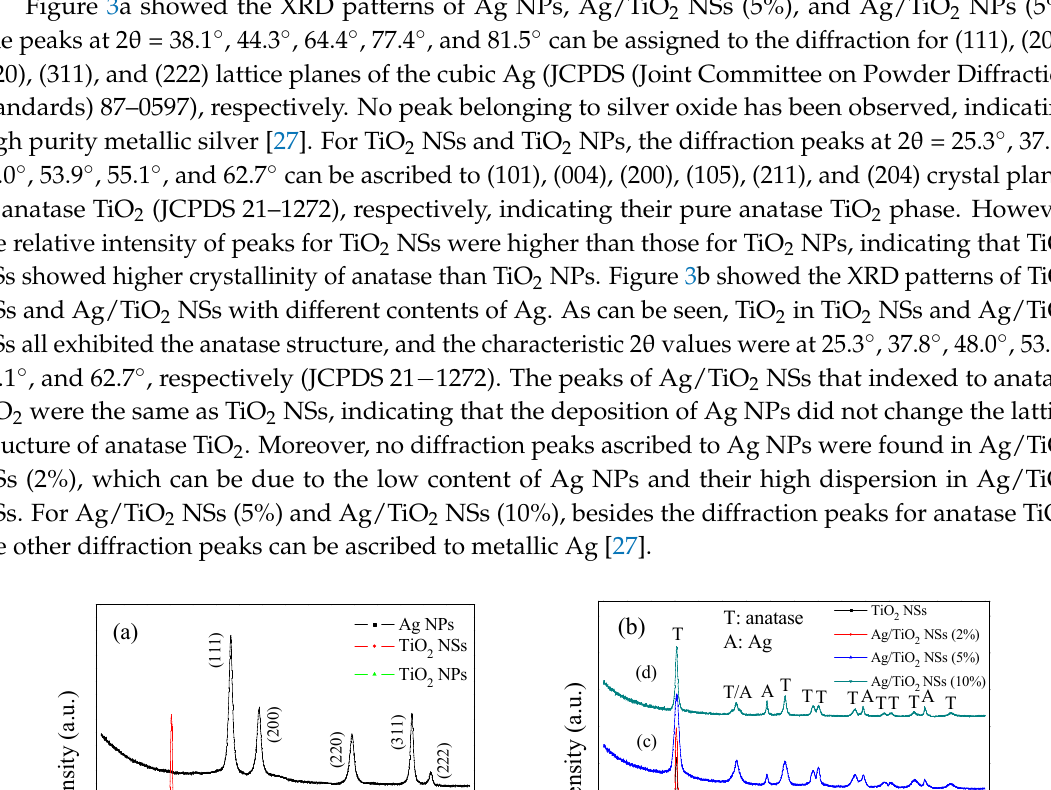
Figure 4. N 2 adsorption-desorption isotherms ( a ) and pore size distribution curves ( b ) of different catalysts. As shown in Figure 5a, all the samples were of the similar peaks, locating at 144 (Eg), 197, 394 (B1g), 514 (A1g), and 636 cm − 1 (Eg), indicating the anatase phase of the samples. It also indicated that the deposition of Ag NPs did not affect the nanostructure of anatase TiO 2 . Furthermore, no silver oxide peak can be detected in the Ag/TiO 2 catalysts, indicating that the Ag NPs in the catalysts were